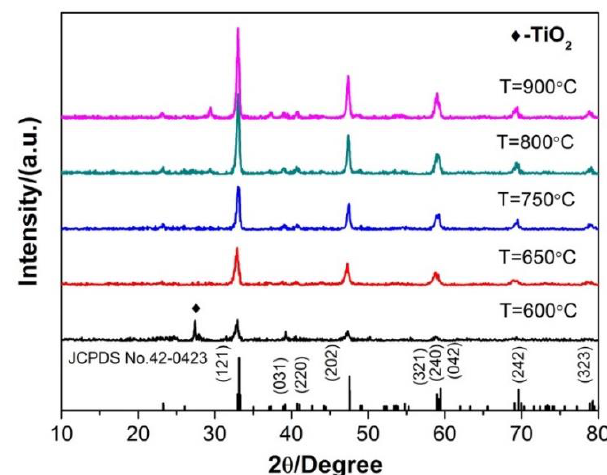
Figure 4. XRD patterns of the Ca 1-x TiO 3 :Eu 3+x phosphor samples at different traditional sintering temperatures and same isothermal holding for 2.5 h.